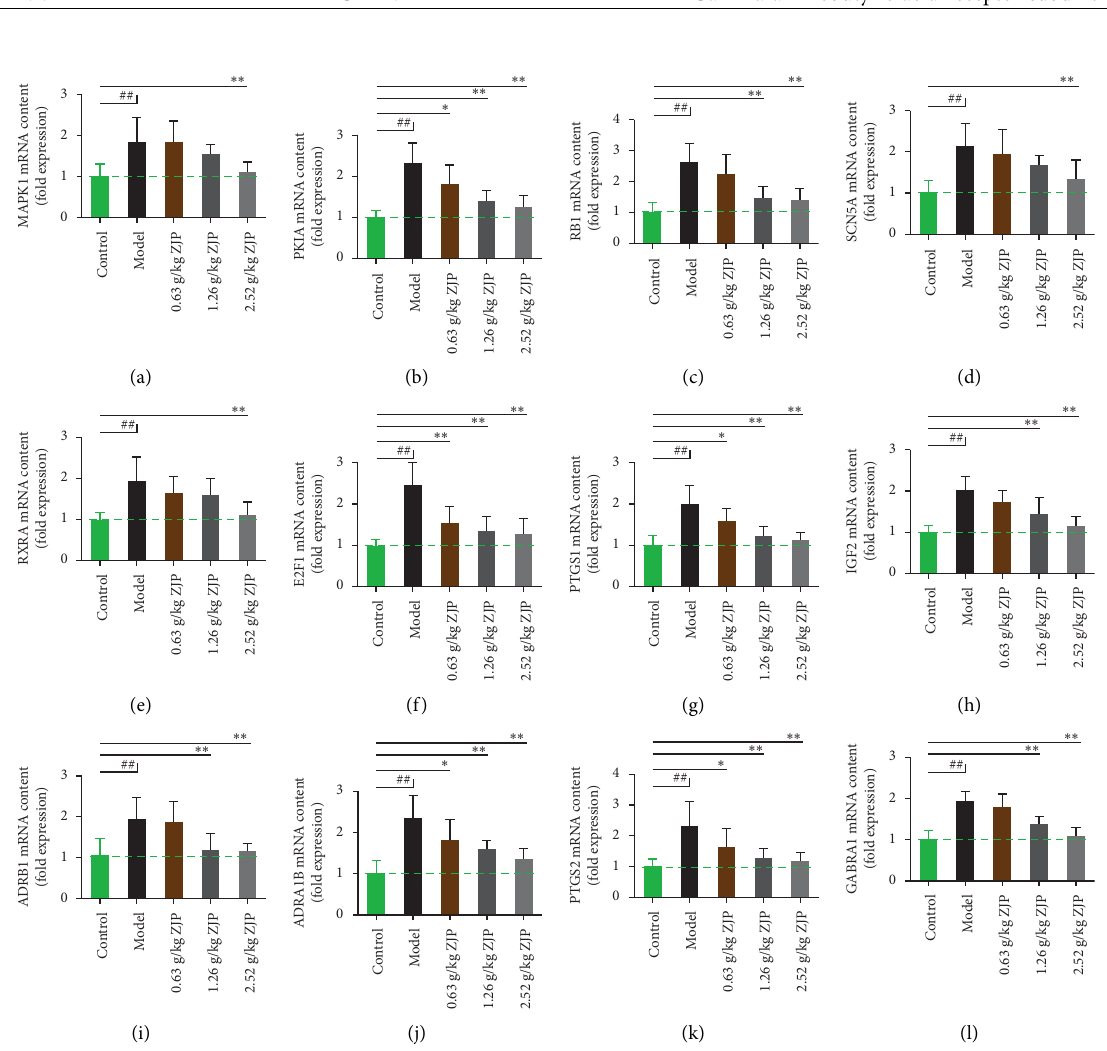
Figure 9: Effect of ZJP on the relative mRNA expressions of MAPK1, PKIA, RB1, SCN5A, RXRA, E2F1, PTGS1, IGF2, ADRB1, ADRA1B, PTGS2, and GABRA1 in CAG rats. (a) MAPK1; (b) PKIA; (c) RB1; (d) SCN5A; (e) RXRA; (f) E2F1; (g) PTGS1; (h) IGF2; (i) ADRB1; (j) ADRA1B; (k) PTGS2; (l) GABRA1. ## P < 0.01, compared with the control group. ∗ P < 0.05 and ∗∗ P < 0.01, compared with the model